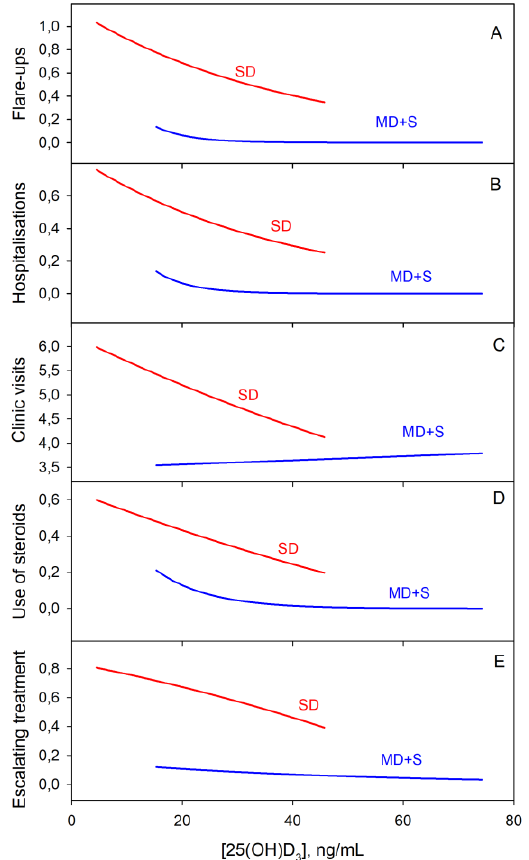
Figure 9. Logistic regression of clinical disease activity markers with vitamin D content. From A to E: Flare-ups, hospitalisations, clinic visits, use of steroids and escalating treatment, respectively.